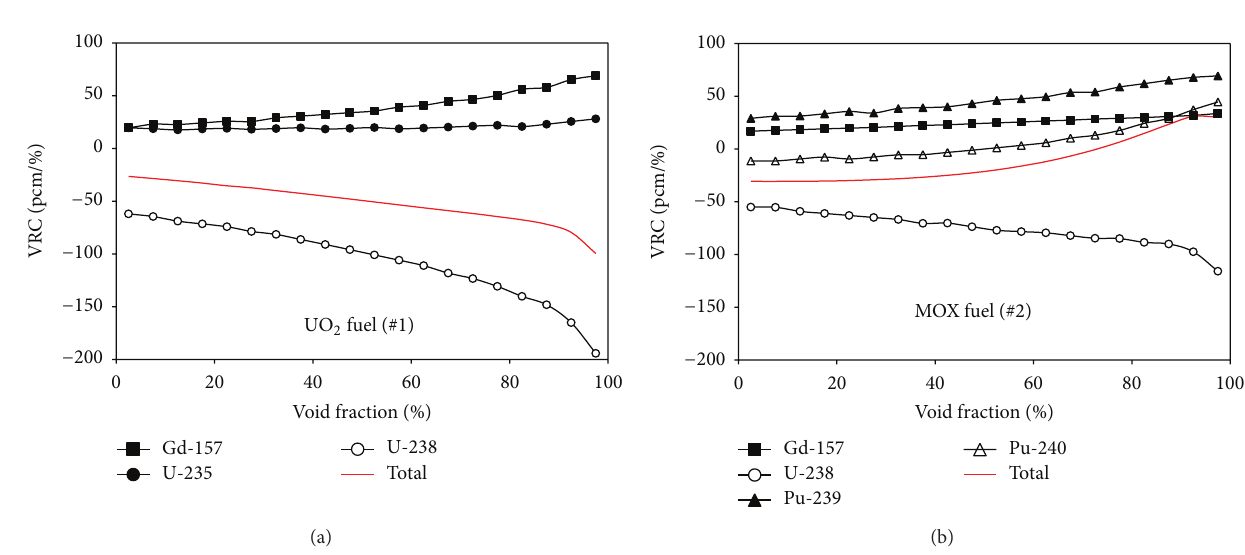
Figure 6: Decomposition of VRC values for separate isotopes in case of UO 2 and MOX